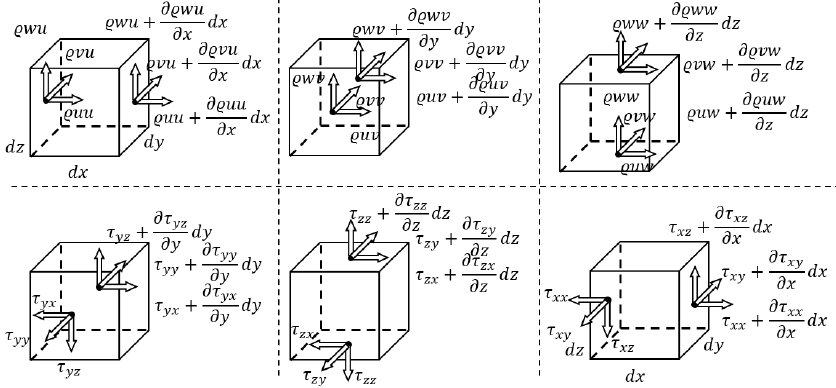
Fig. 1. Differential volume element as a theoretical construct used to derivate a conservation law (Navier-Stokes equation), split into six sub elements to improve clarity [2]